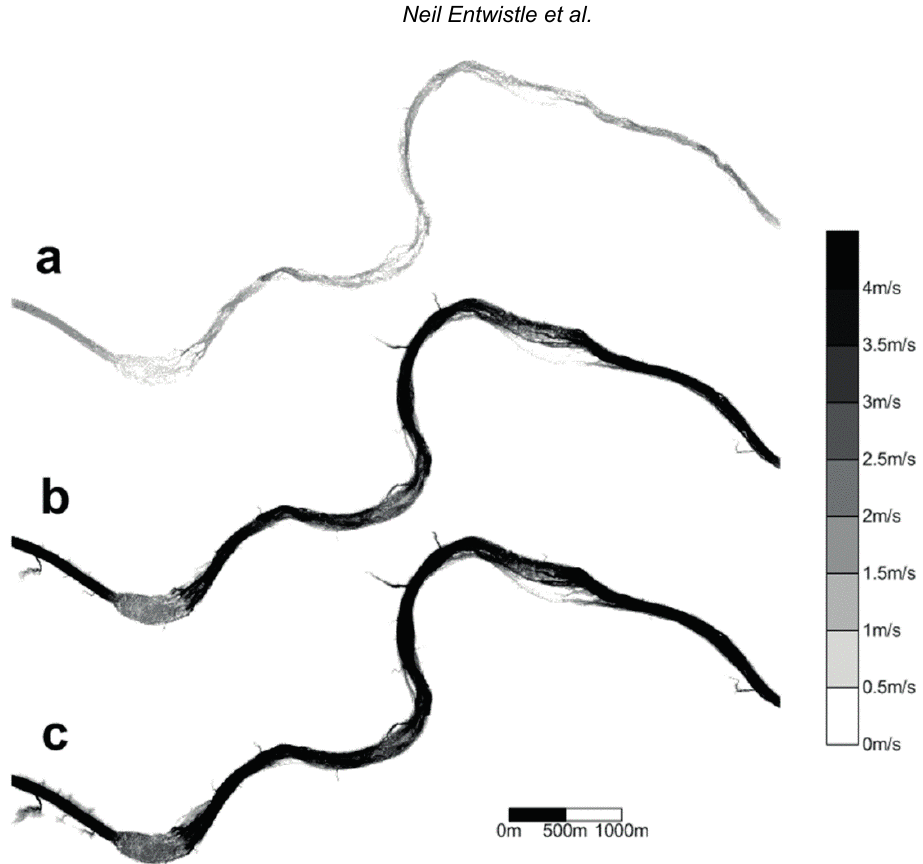
Fig. 4 Simulated flow velocities for an alternating alluvial (single thread, braided) and mixed anastomosing reach of the Sabie River for discharges of 1500, 3500 and 5000 m 3 s -1 ; flow is left to right.